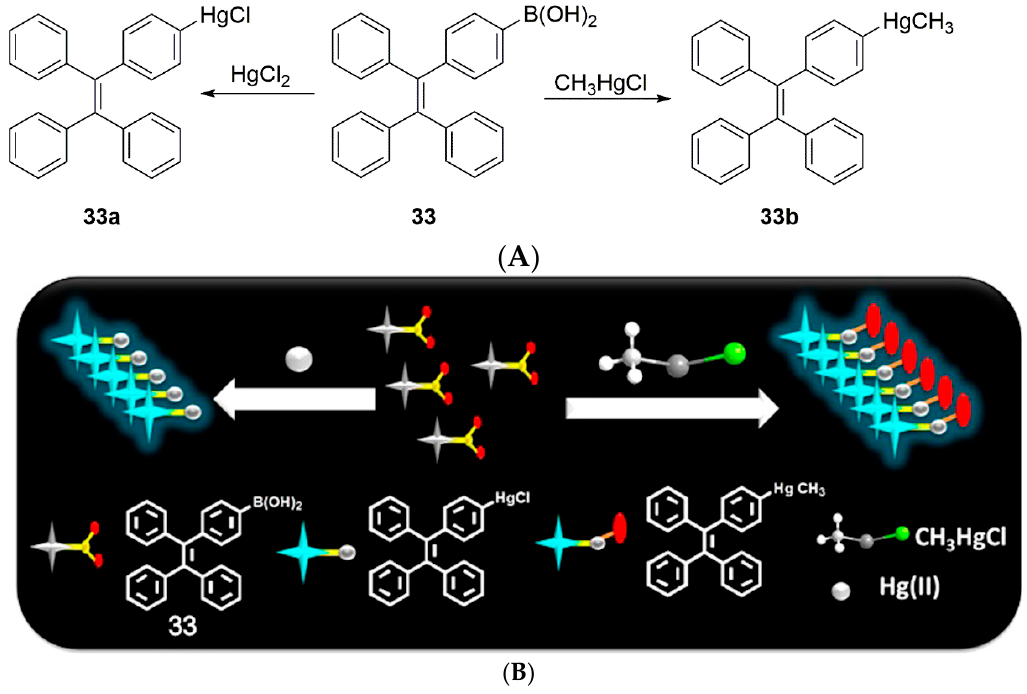
Figure 14. Schematic representation of the sensing process of chemodosimeter 32 on the addition of Hg 2+ ion and CH 3 Hg + . Reprinted (adapted) with permission from [195]. ( A )Chemical Scheme,